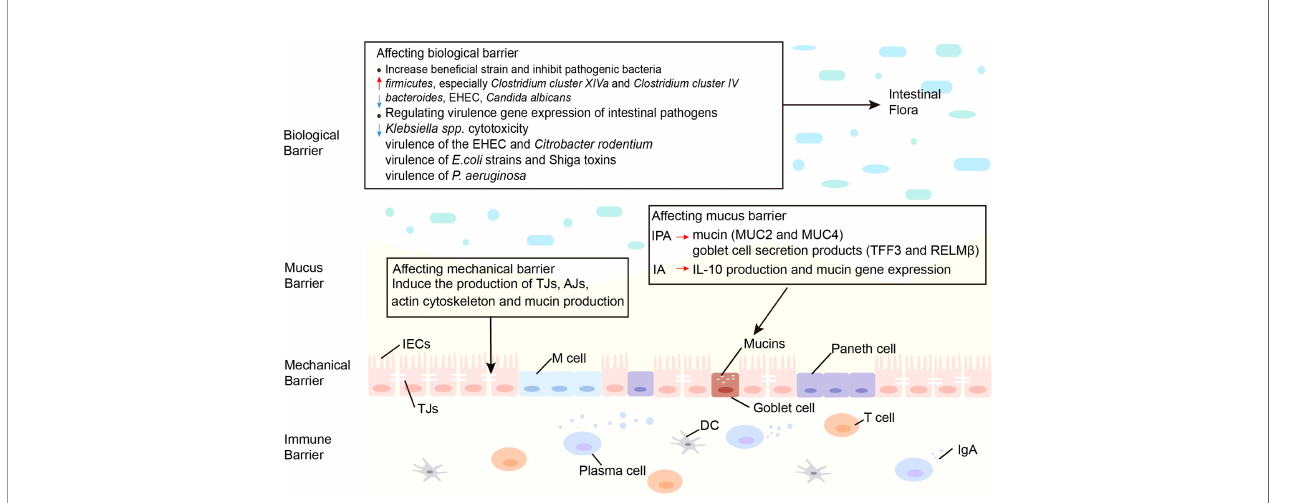
FIGURE 2 | Effects of indoles on three barriers. Indoles affect the biological barrier by increasing bene fi cial bacteria, inhibiting pathogenic bacteria and regulating virulence gene expression of intestinal pathogens. Indoles enhance intestinal epithelial cell function by regulating several genes involved in mechanical barrier formation. Indoles increase mucin and goblet cell secretion products, which strengthen the mucus barrier. AJs, adherens junctions; DC, dendritic cell; E. coli , Escherichia coli ; EHEC, enterohemorrhagic escherichia coli ; IA, indoleacrylic acid; IECs, intestinal epithelial cells; IgA, immunoglobulin A; IL-10, interleukin-10; IPA, indole 3-propionic acid; MUC, mucin; M cell, membranous cell; P. aeruginosa , Pseudomonas aeruginosa ; TJs, Tight